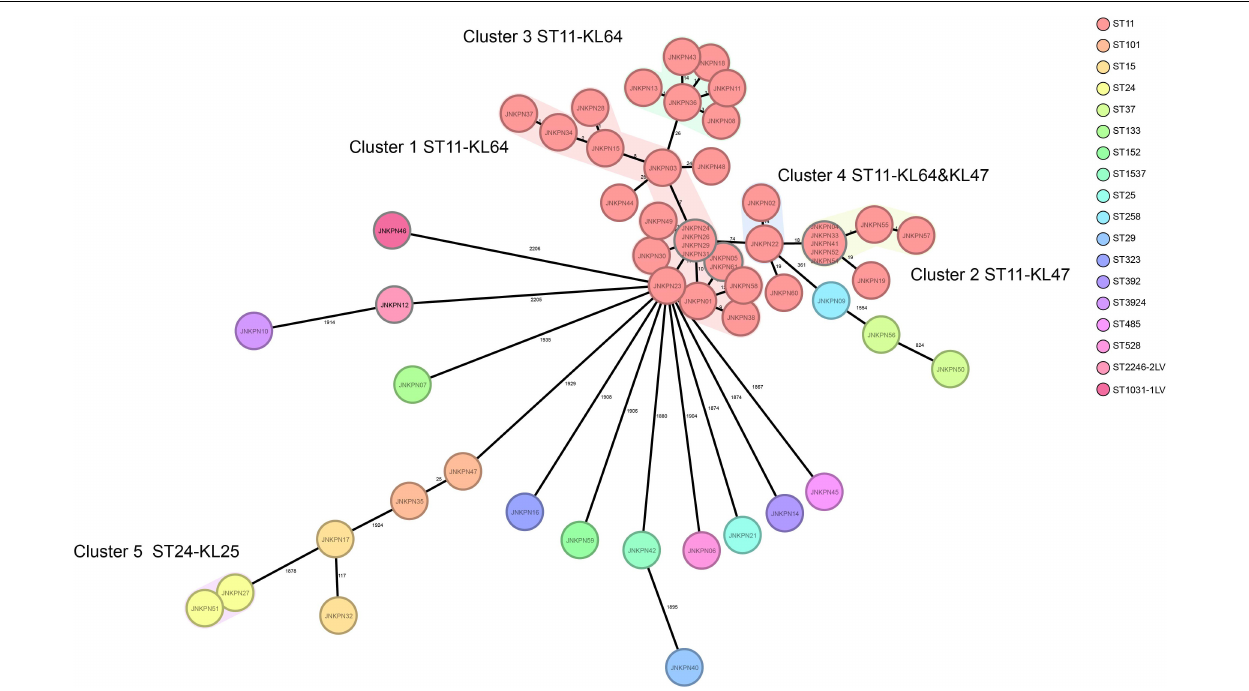
FIGURE 3 | Minimum spanning tree showing core genome multilocus sequence typing (cgMLST) of the 57 carbapenem-resistant Klebsiella pneumoniae (CRKP) isolates, showing five cluster types numbered consecutively. Each circle represents an allelic profile. Colors of circles indicate the different sequence types (STs). Cluster types consist of closely related genotypes ( ≤ 15 allele differences). The numbers on the connecting lines illustrate the numbers of target genes with different